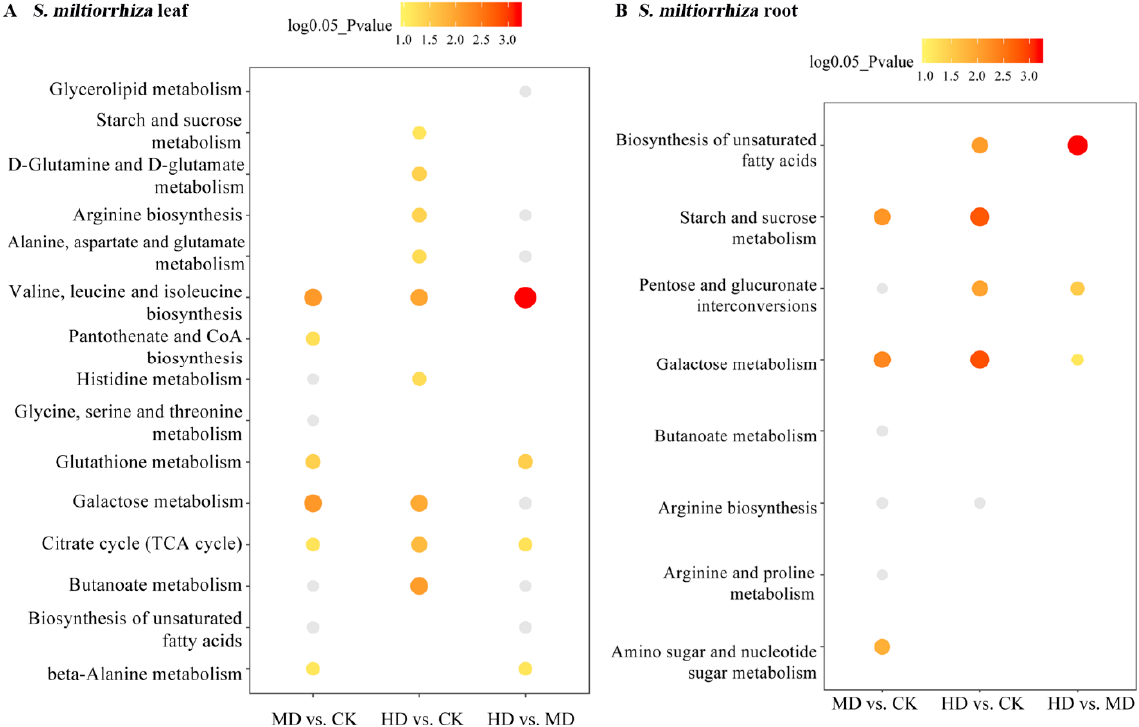
Figure 3. The metabolic pathway enrichment analysis of differential metabolites in Salvia miltiorrhiza Bunge. ( A , B ): the pathways related to differential metabolites in S. miltiorrhiza leaf and root, respectively. Significantly differential metabolites were identified using the thresholds of fold change (FC) ≥ 1.5 or ≤ 0.67 (|log2FC| ≥ 0.585) and p < 0.05.